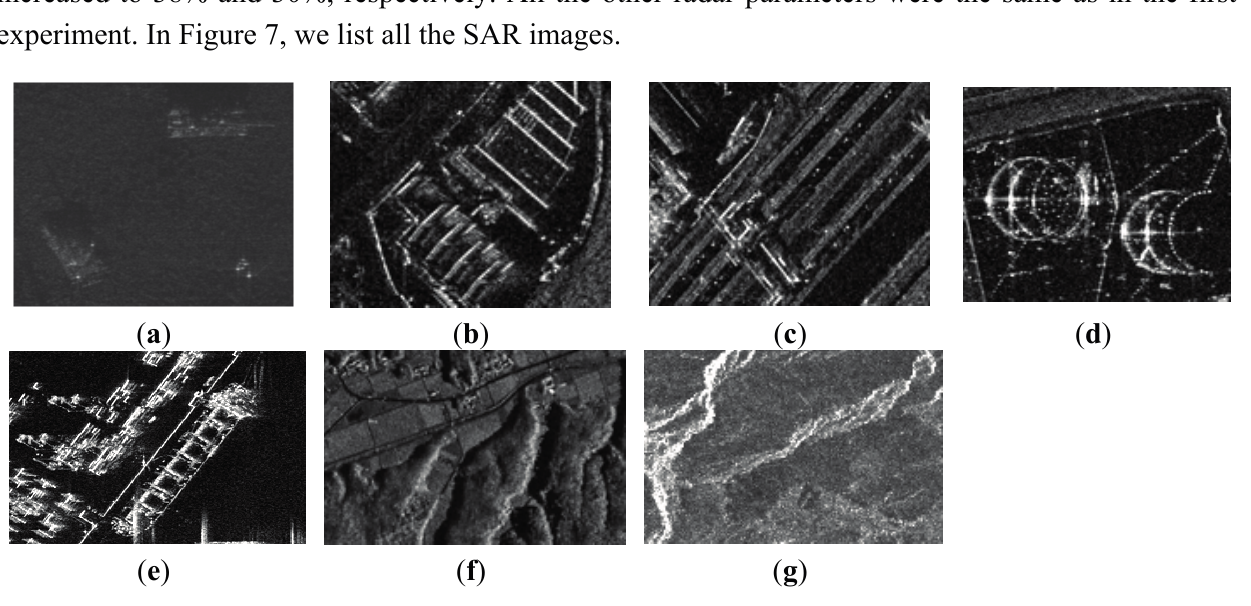
Figure 7. Test images. ( a ) Image 1; ( b ) Image 2; ( c ) Image 3; ( d ) Image 4; ( e ) Image 5; ( f ) Image 6; ( g ) Image